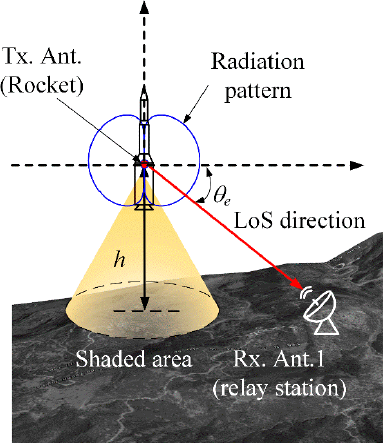
Figure 7. Relation between the elevation angle and the rocket’s altitude in the LoS direction.